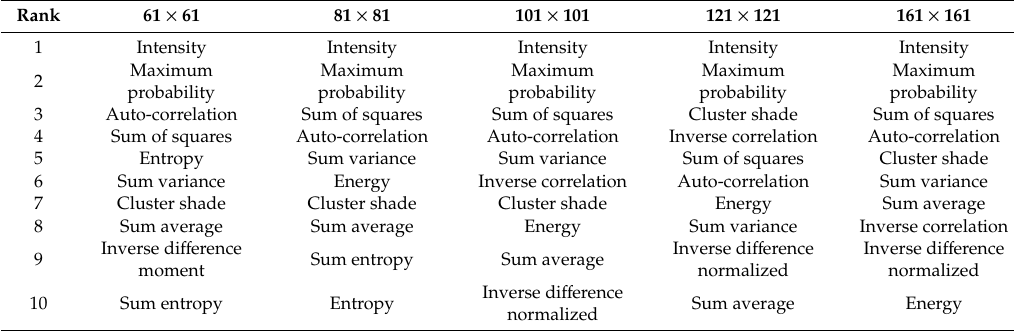
Table 2. Feature ranking based on the reliefF